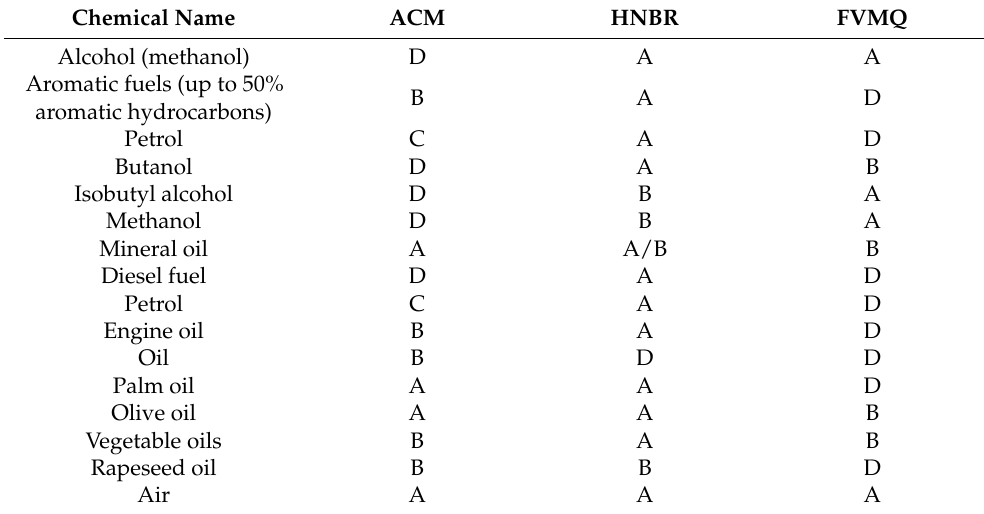
Table 1. Chemical resistance and compatibility of elastomer materials with different chemicals (evaluating system—A: very good applicability, no or minimum influence on the change in physical properties; B: very good resistance, a mild change in physical properties; C: limited applicability, it can lead to a significant change in physical properties; D: not recommended for use, unsuitable combination; X: not possible to evaluate)